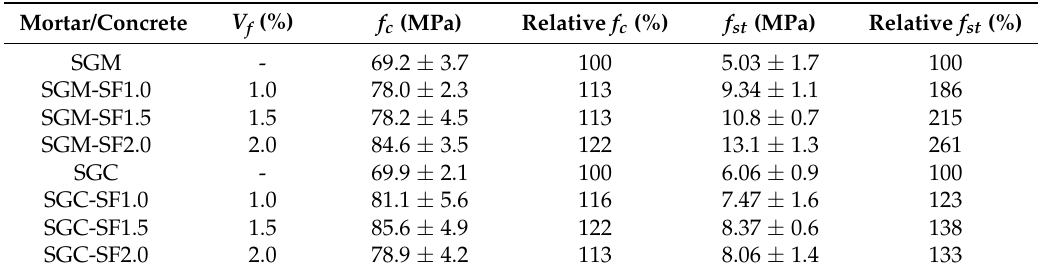
Table 4. Average compressive and splitting tensile strengths of unreinforced and steel fiber-reinforced SGM and